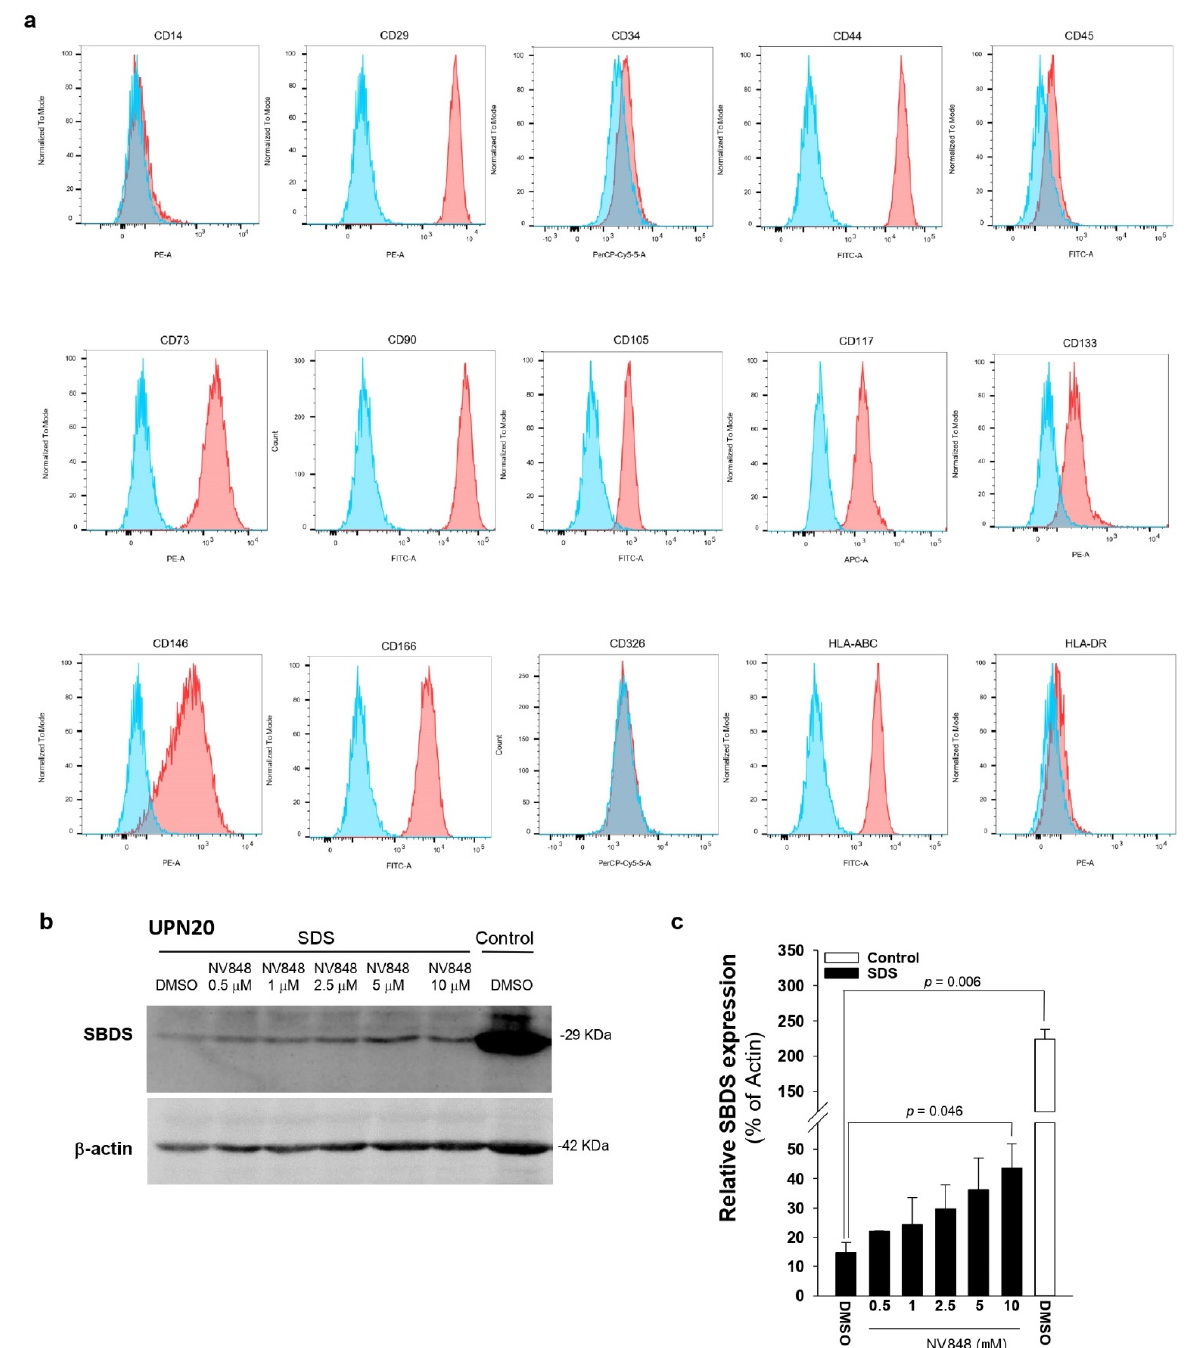
Figure 5. NV848 restores SBDS protein expression in nonhematopoietic PDLSC obtained from SDS patients. ( a ), Immunophenotypic profile of SDS-PDLSC. Cells isolated from the periodontal ligament of patients with SDS were incubated with fluorescent-conjugated antibodies against CD14, CD29, CD34, CD44, CD45, CD73, CD90, CD105, CD117, CD133, CD146, CD166, CD326, HLA-ABC, and HLA-DR, and analyzed by flow cytometry. Red histograms represent cells stained with the relevant antibody; blue histograms show the corresponding IgG isotype control. Data are representative of 4 different samples obtained from 4 patients with SDS. ( b ), PDLSCs from UPN20, or from healthy donor (Control) were incubated with increasing doses (0.5–10 µ M) of NV848, or vehicle alone (DMSO) for 24 h. SBDS protein expression was quantified by Western blot analysis. ( c ), Densitometry of bands depicted in panel ( b ). Data are mean ± SEM of 4 independent